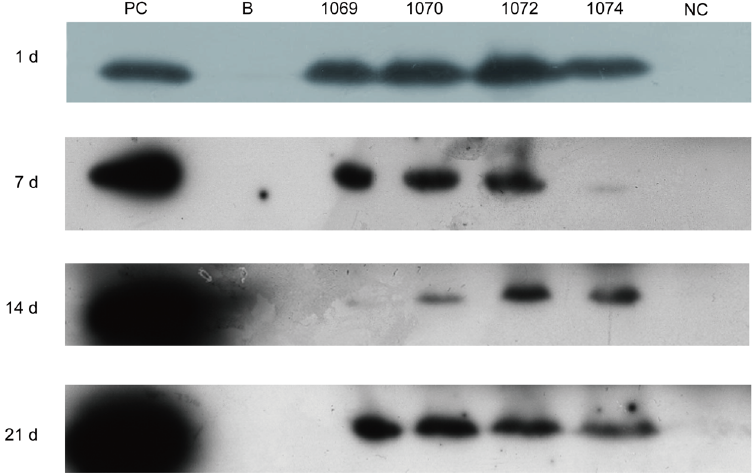
Fig 5. Detection of rhLZ in plasma of piglets. Blood samples were detected by western blot analysis. PC, commercial natural hLZ (1 μ g); NC, blood from piglets nursed by WT sows; lanes 3 – 6, diluted blood samples (5 μ L) from piglets nursed by transgenic sows.